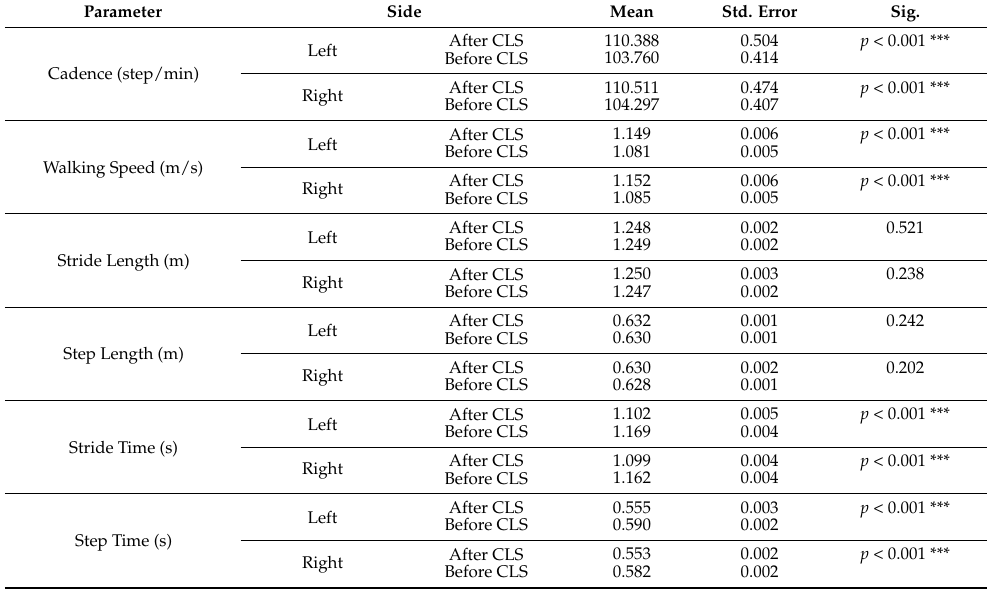
Table 2. Temporospatial parameters.